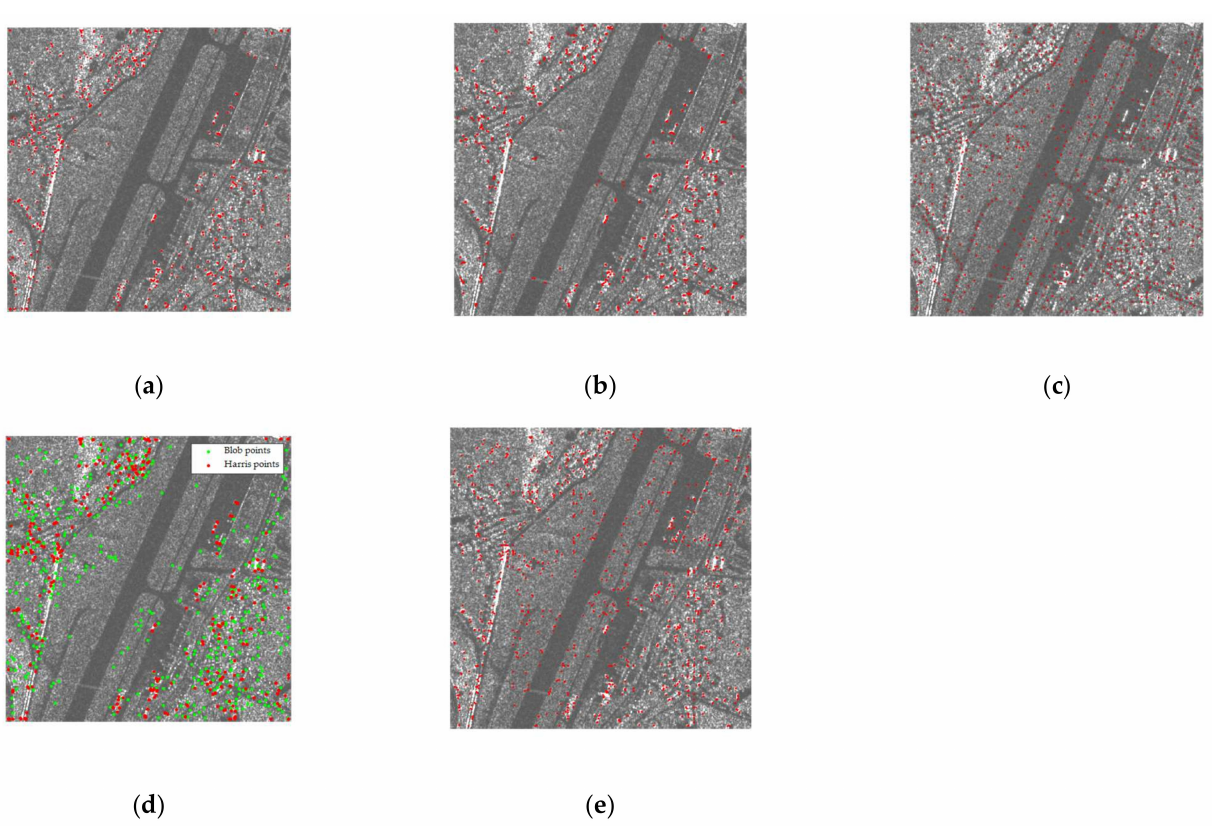
Figure 12. Detection results of five detectors on spaceborne SAR images: ( a ) Har-Lap. ( b ) SAR-Harris. ( c ) DoG. ( d ) Har-DoG. ( e )